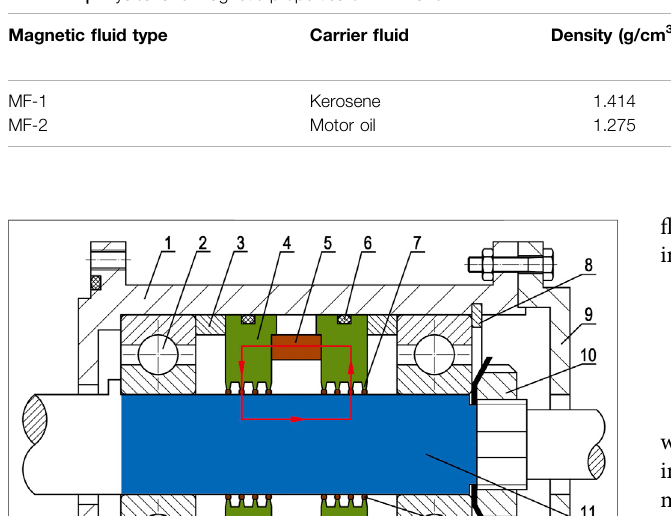
TABLE 1 | Physical and magnetic properties of MF-1 and MF-2.